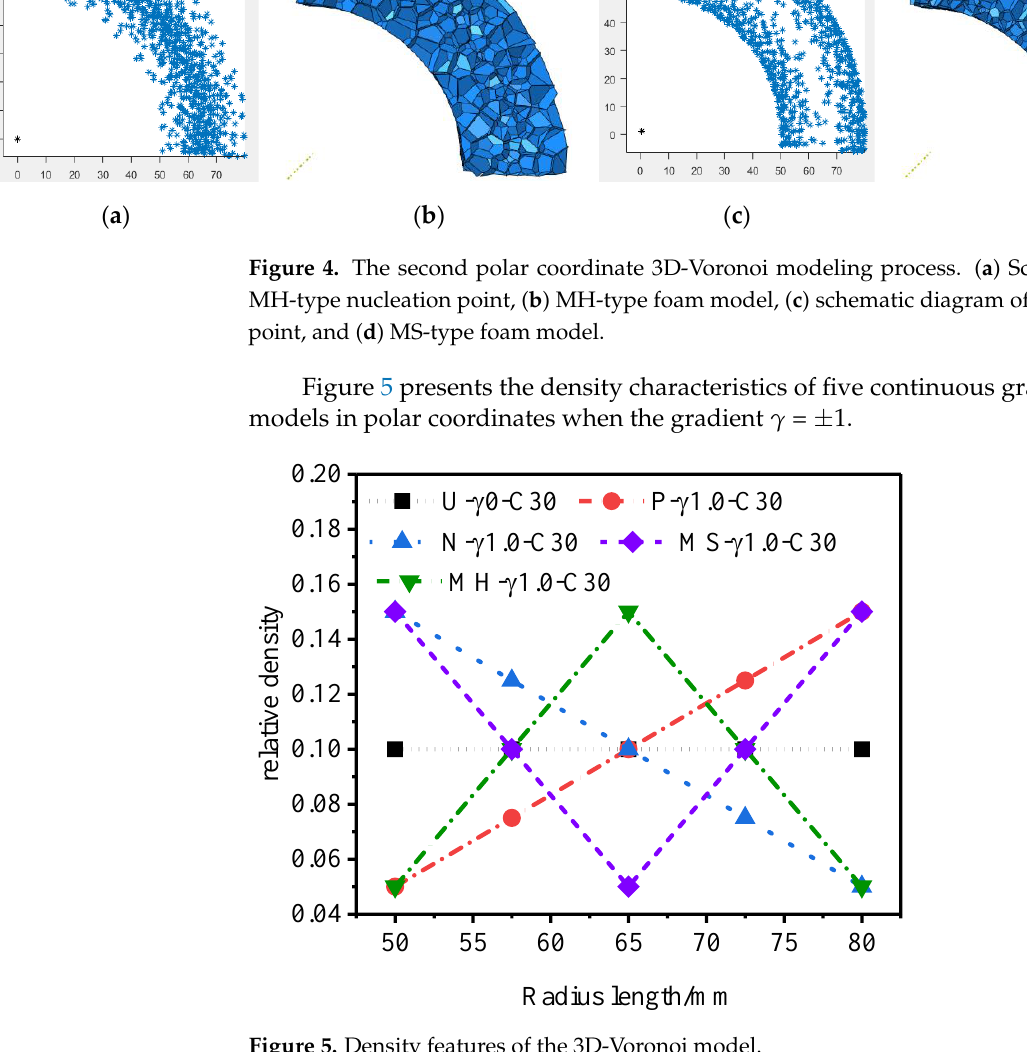
Figure 5. Density features of the 3D-Voronoi model.